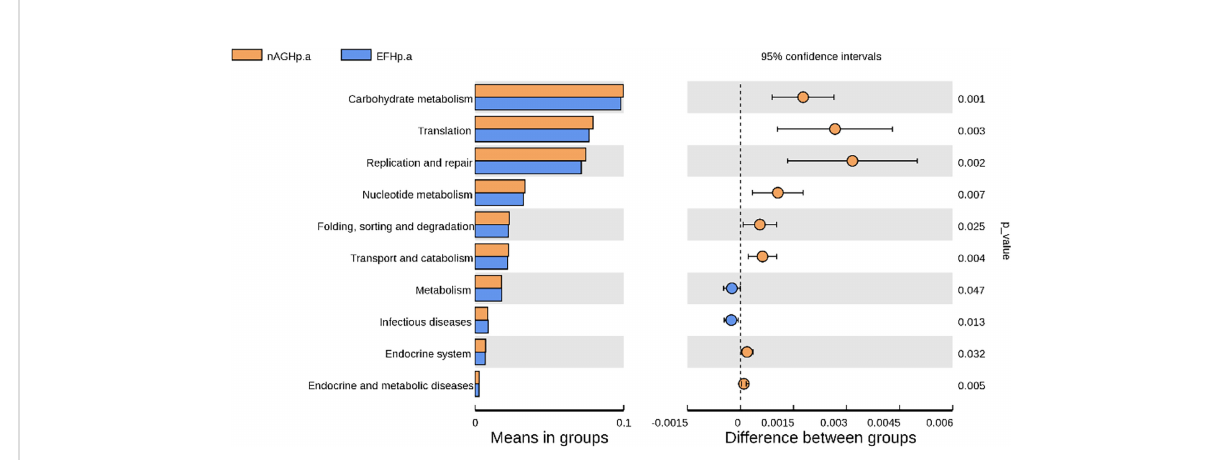
FIGURE 8 The predicted gastric microbiota function in KEGG pathway at levels 2 between group nAGHp.a and group